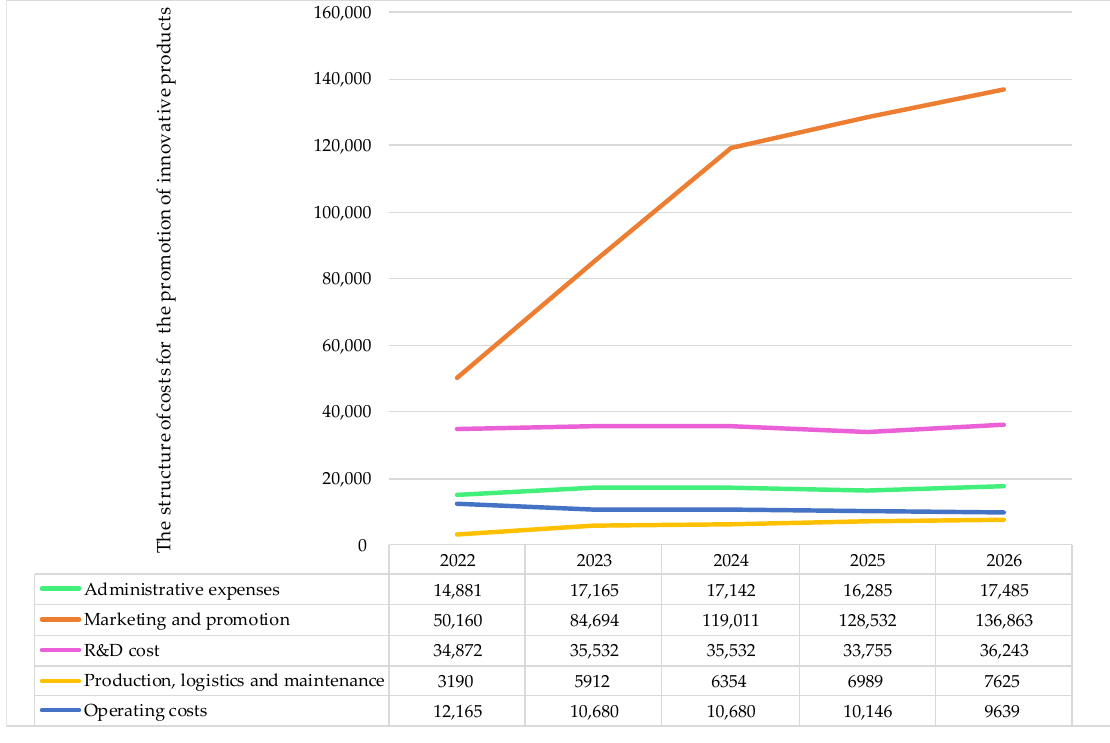
Figure 6. Dynamics of projected gross profit of Hideez Technology in 2022–2026, US dollars. Due to the significant cost of promotion of Hideez Key at the initial stage, in 2022 Hideez Technology LTD expects to incur a total loss of USD 47,850. Already, rapid growth is projected for 2023—net profit will reach USD 147,737, and by the end of 2026 it will increase 4.6 times (Figure 7).